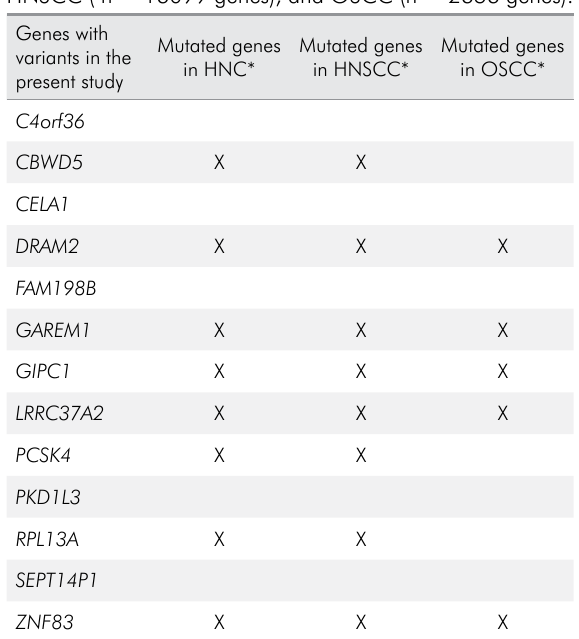
Table 4. Similarities of genes with variants identified in OED samples from the present study (n = 15 genes), with the groups of genes mutated in samples of HNC (n = 16807 genes), HNSCC ( n = 16099 genes), and OSCC (n = 2656 genes).